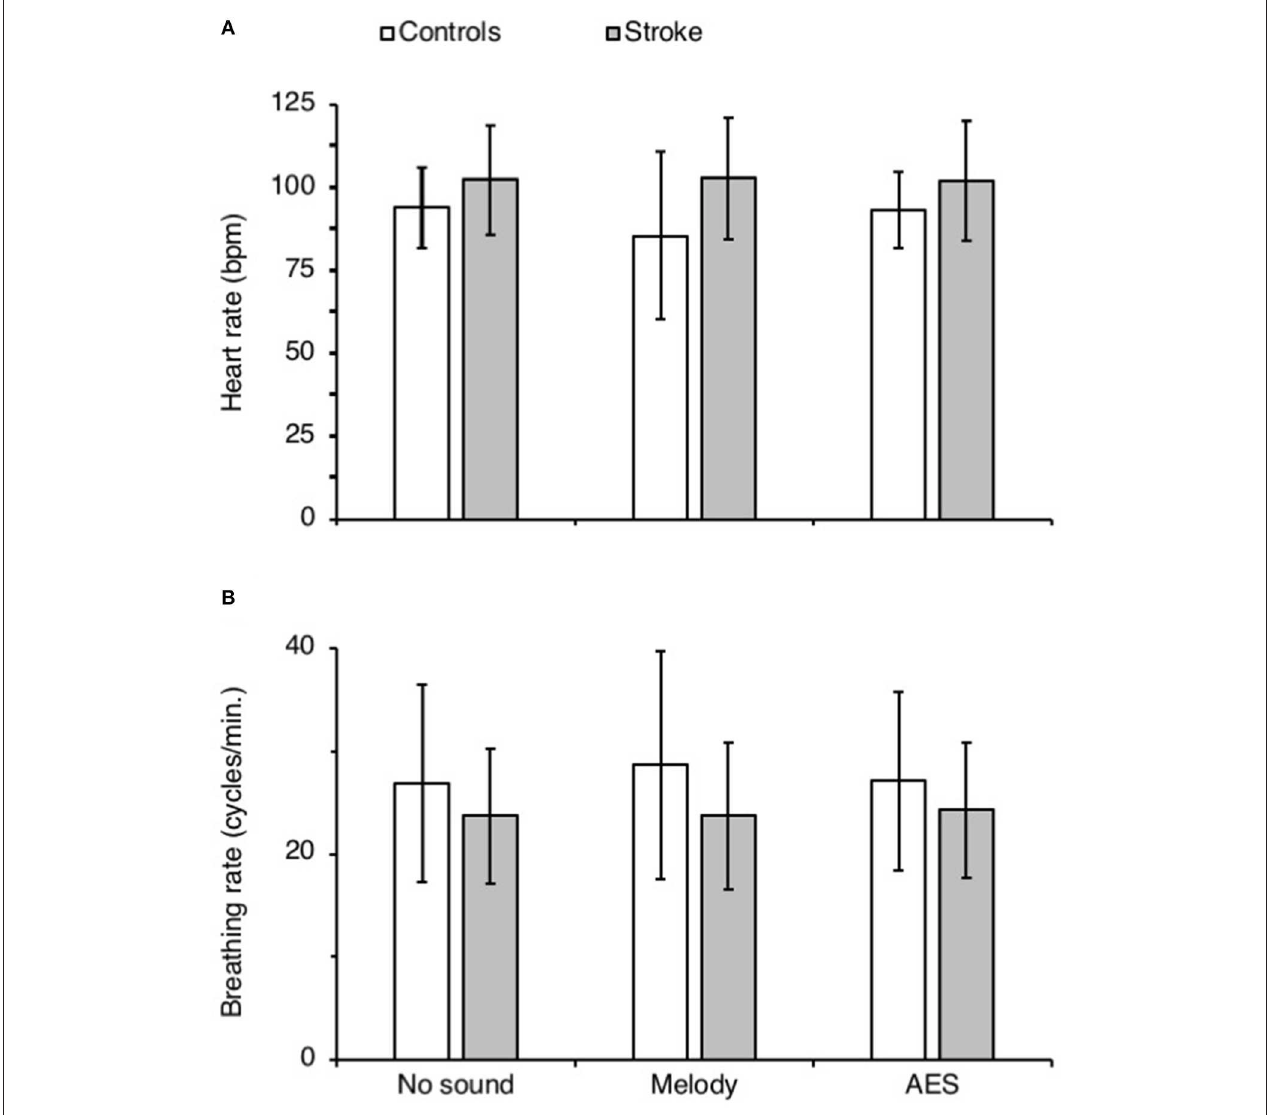
FIGURE 5 | Physiological parameters. (A,B) Mean heart (bpm, A ) and breathing rate (cycles.min. − 1 ) in controls (white columns) and in patients with stroke (gray columns), calculated during each recording session with (Melody or AES) and without music (No sound). The vertical error bars indicate ± 1 × SD.